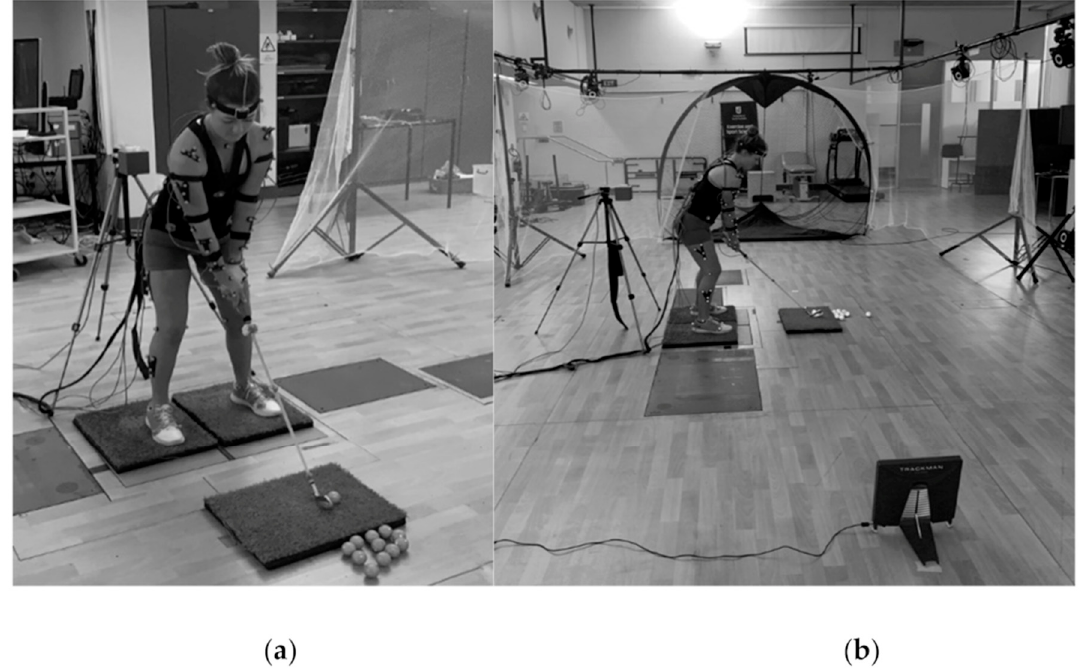
Figure 1. Participant and laboratory set up using the Polhemus Liberty and VICON Nexus motion capture systems: ( a ) Frontal view; ( b ) Rear